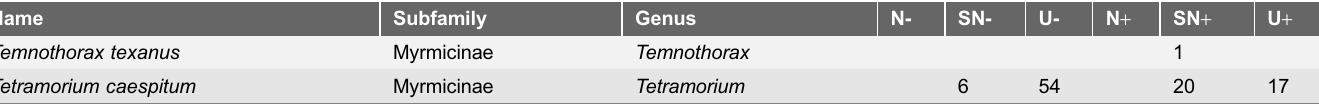
Numbers following species correspond to the number of nests found within the respective factor combinations. Absence of a number indicates absence of the respective species within factor combination. Column abbreviations N, SN, U correspond with natural, semi-natural, and urban habitats. Negative or positive column abbreviations indicate the absence (-) or presence ( + ) of T. sessile .